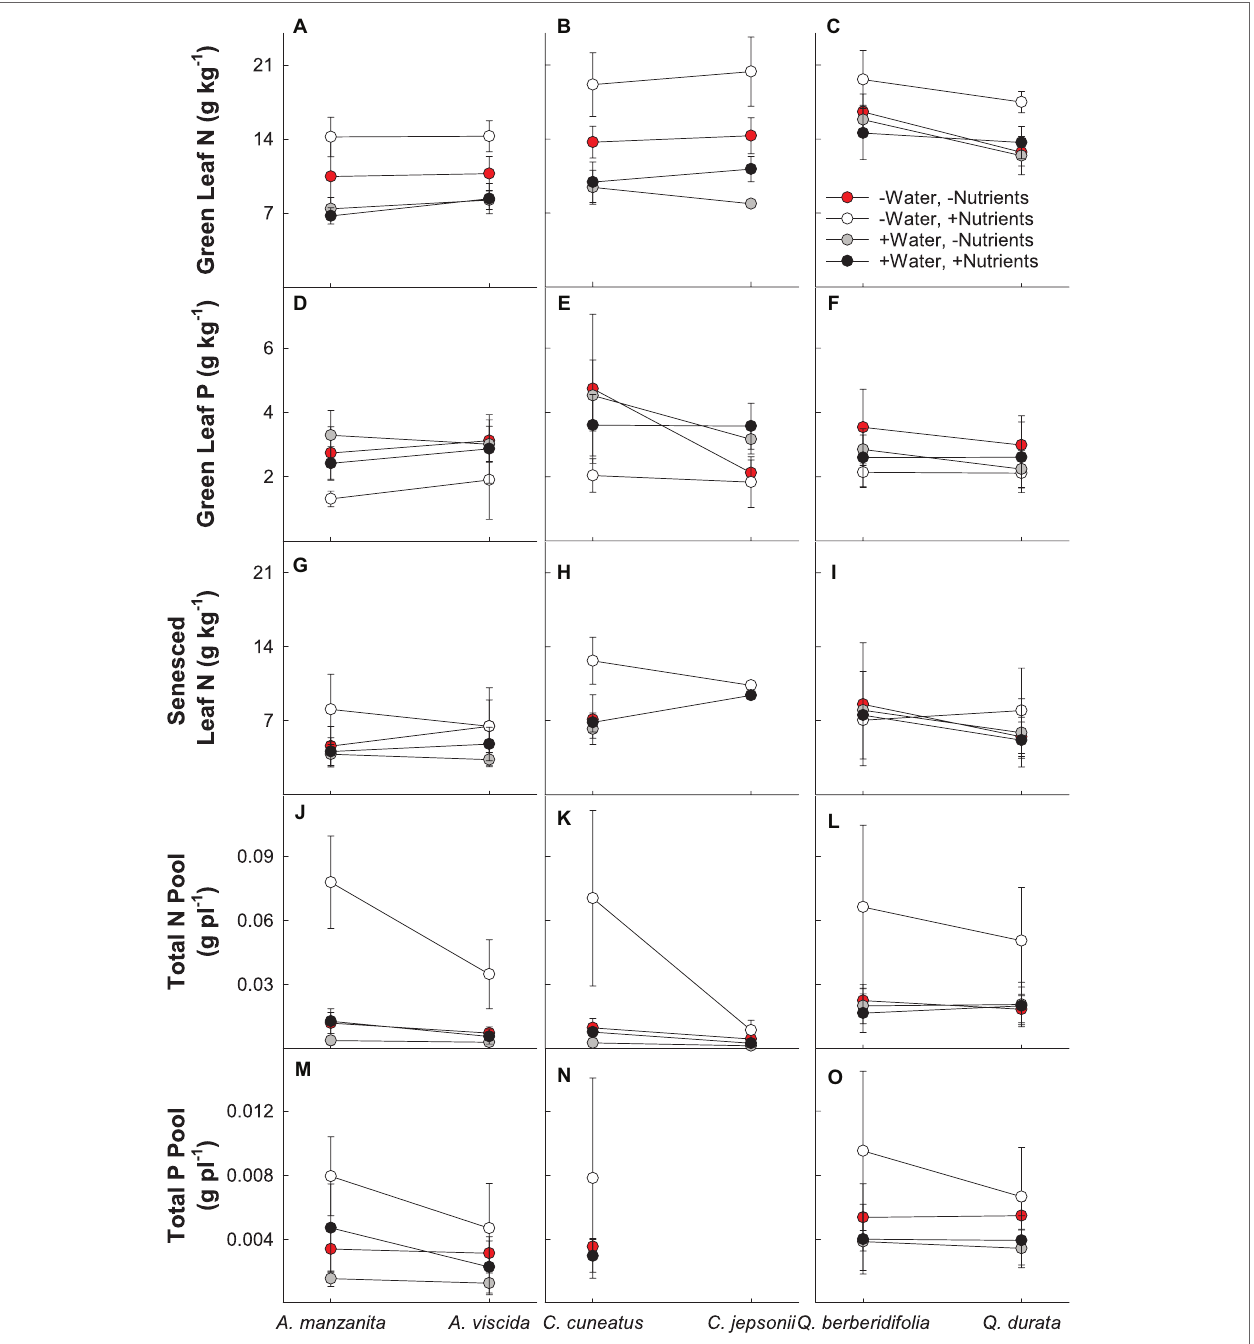
FIGURE 3 | Plant nutritional responses to contrasting water and nutrient treatments, including green leaf N (A–C) , green leaf P (D–F) , senesced leaf N (G–I) , total N pool (J–L) , and total P pool (M–O) . First plant in each congener pair originates from non-serpentine soil; second plant in each congener pair originates from serpentine soil. Data are means ± S.D. ( n =